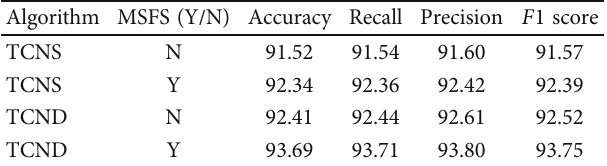
Table 6: The average accuracy of 10-gesture recognition (%).